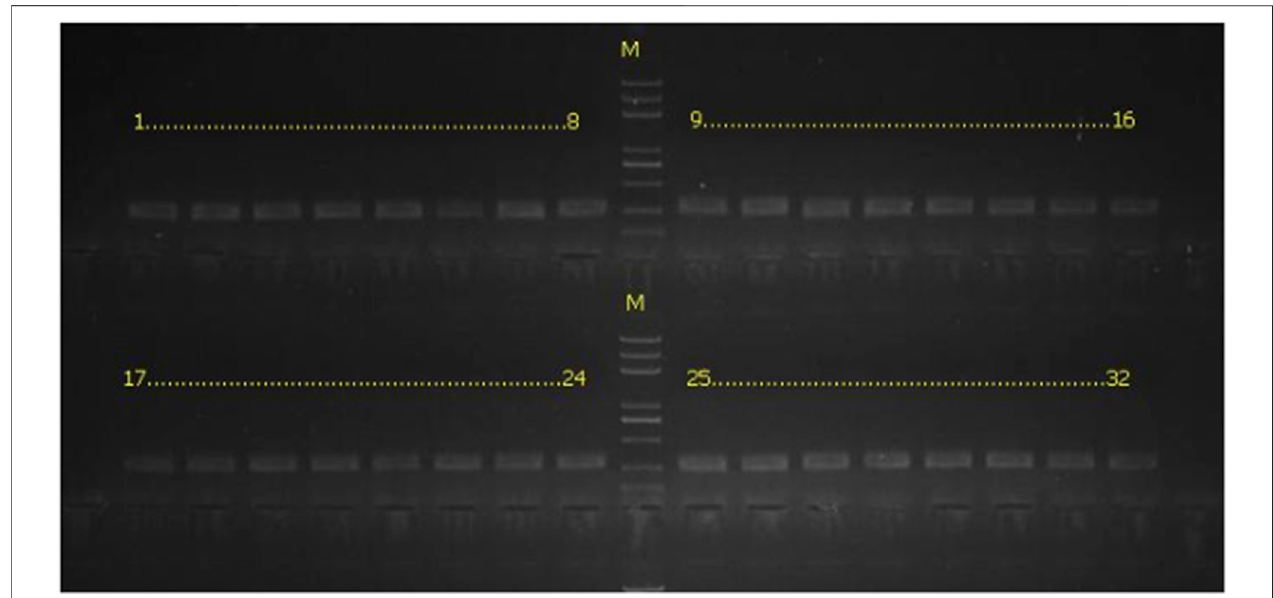
FIGURE 2 | PCR ampli fi cation products